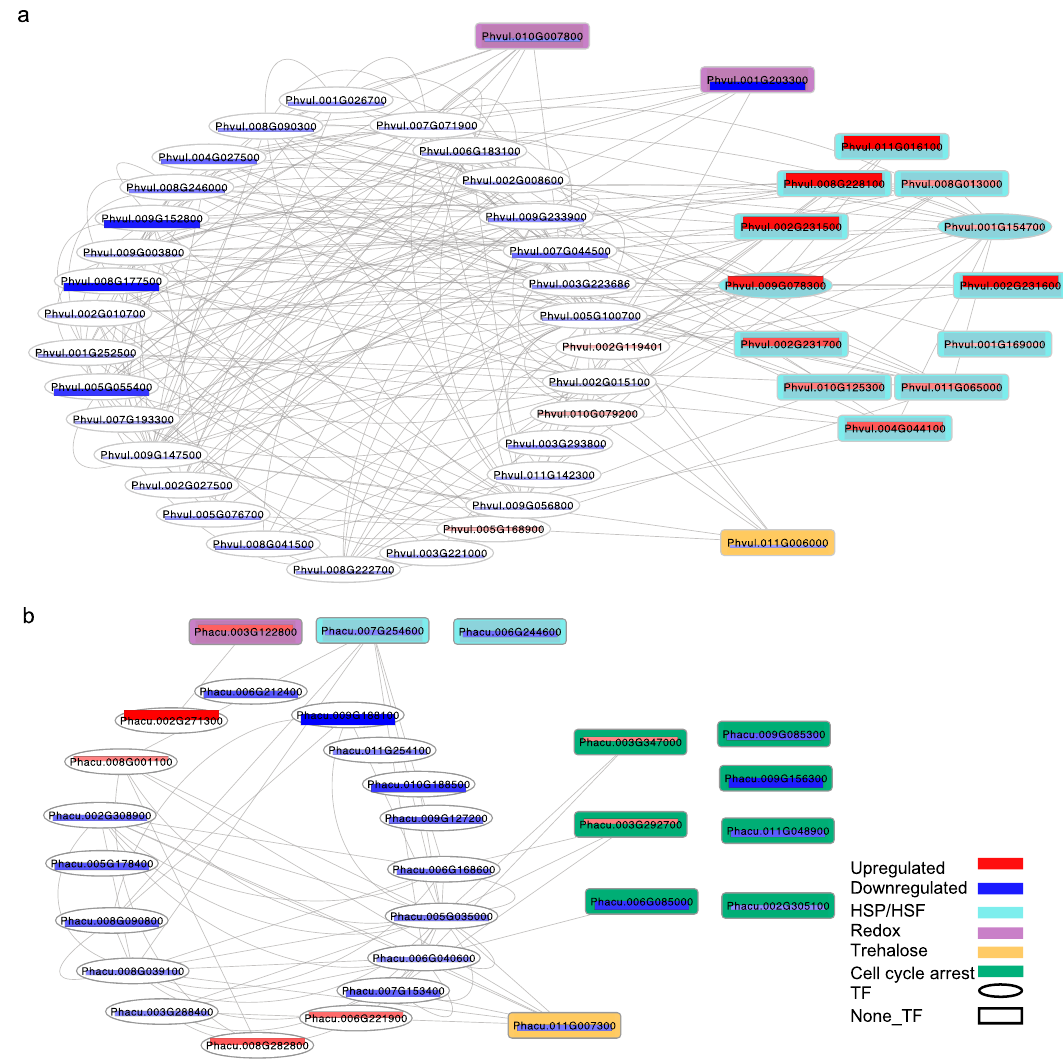
Fig. 2 Response to moderate heat stress in tepary bean. Gene expression network showing different early responses to moderate night temperature (32 °C day/27 °C night) between Phaseolus vulgaris Amadeus-77 ( a ) and Phaseolus acutifolius Frijol Bayo ( b ). The network was created by ARACNeAP 95 . Transcription factors (TF) are within ovals and non-TF genes are within rectangles. Upregulation and downregulation of each gene is indicated by red and blue bars within the gene names. The width of the bars re fl ects the magnitude of the difference in relative expression values. Genes encoding heat shock proteins/heat shock factors (HSP/HSF), redox, trehalose, and cell cycle arrest are colored in aqua, lavender, goldenrod, and light